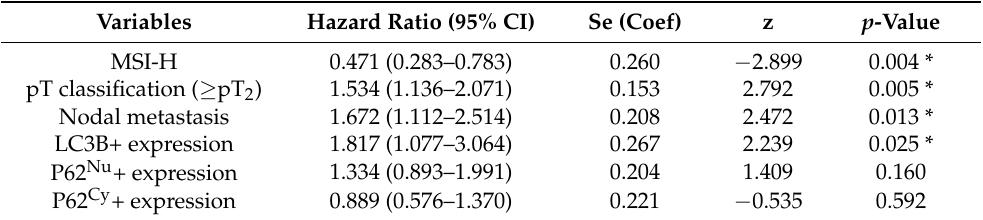
Table 6. Cox proportional multivariate analysis of the association between prognostic variables and OS in SIAC